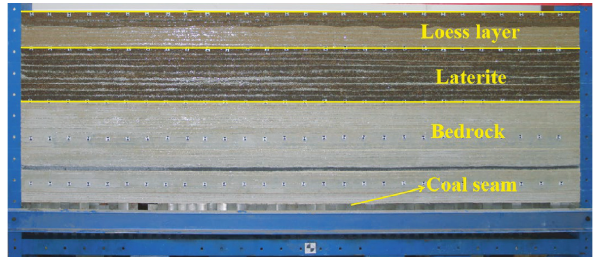
Figure 7: Similarity simulation experimental model.